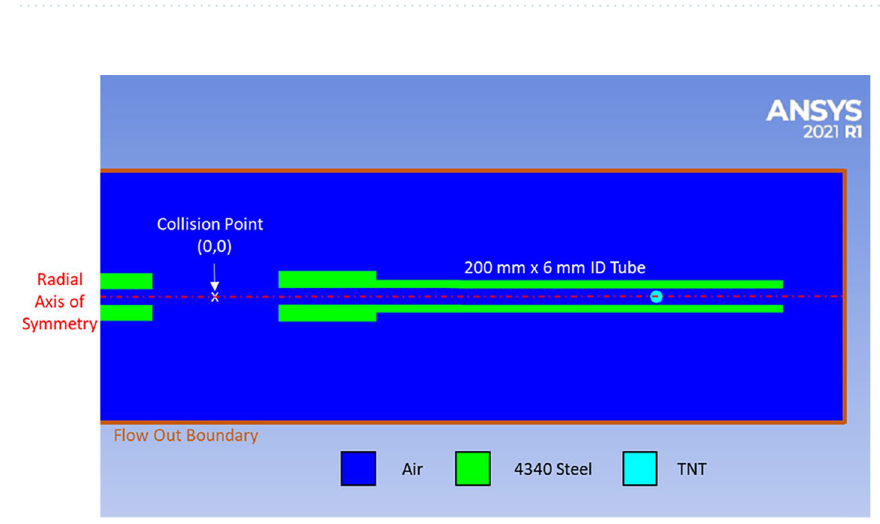
Figure 8. Section view of coupled Lagrangian/Eulerian vortex collision simulation setup mirrored about the axis of